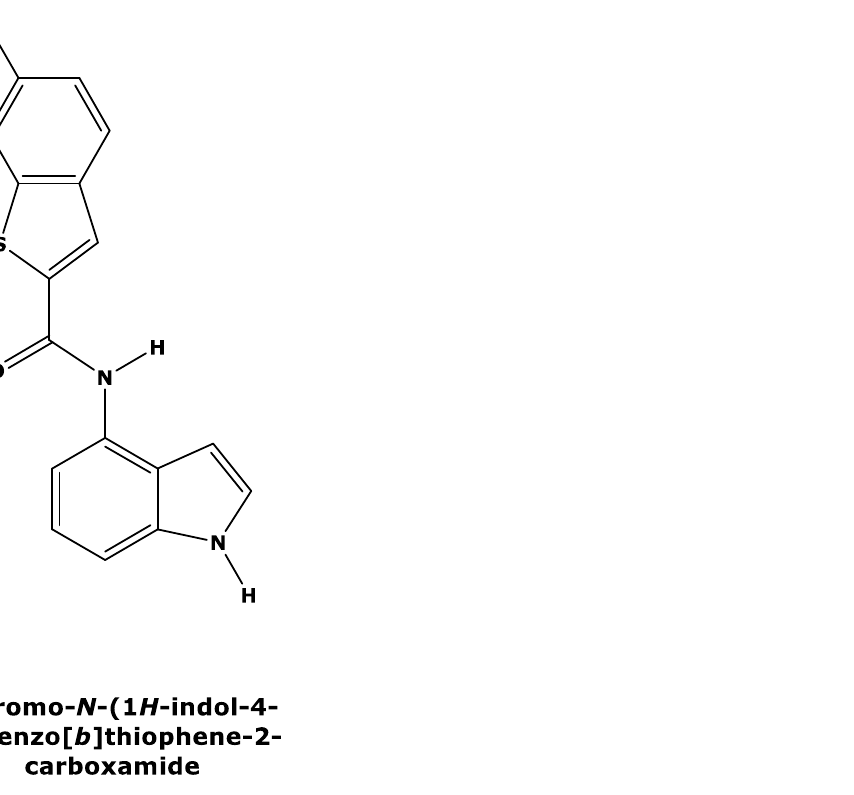
Figure 2. Two-dimensional structure of compound 6-bromo- N -(1 H -indol-4yl)-1-benzothiophene-2- carboxamide (PubChemCID146014943).